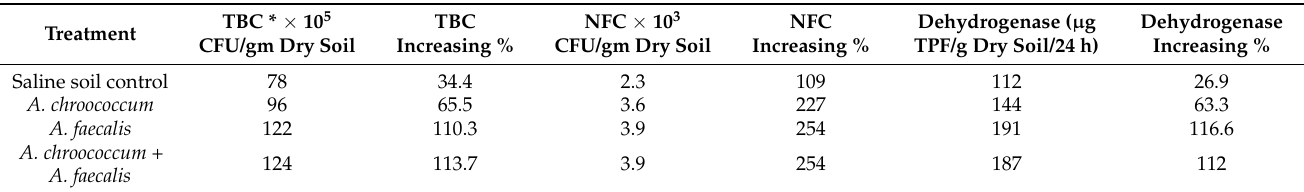
Table 1. Effect of bacterial inoculation on the microbial characteristics of the rhizosphere. TBC: total bacterial count, NFC: nitrogen fixer